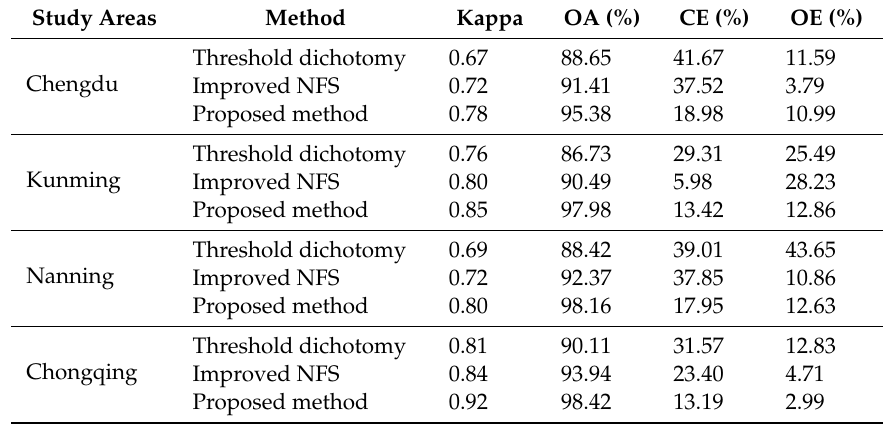
Table 2. Comparison of the obtained accuracy and error values among the di ff erent algorithms. Study